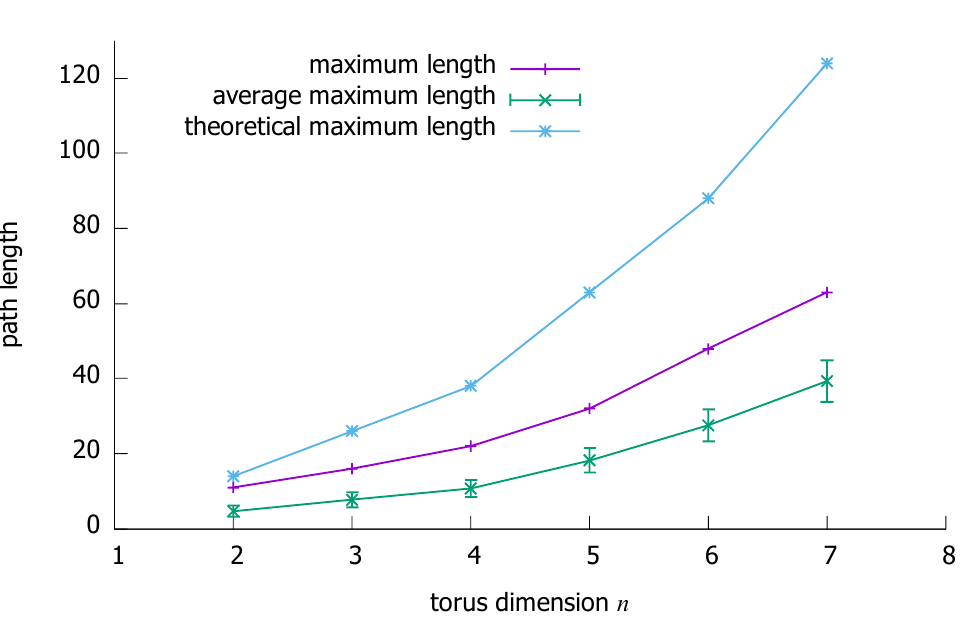
Figure 9. Empirical evaluation: maximum and average maximum (with standard deviation) path lengths of paths selected by the proposed algorithm in an ( n , max { 5, n + 1 } )-torus.